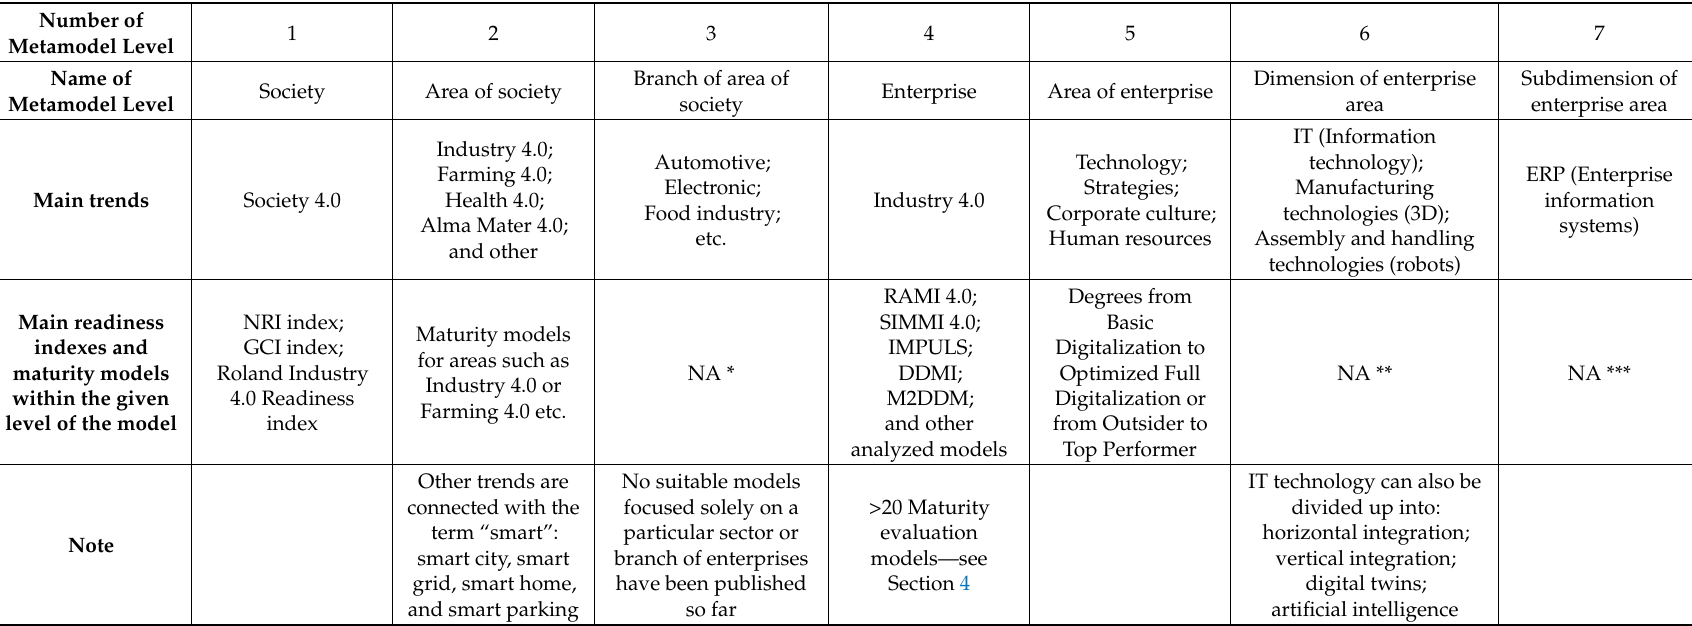
Table 2. A metamodel of an enterprise’s readiness for Industry 4.0 within Society